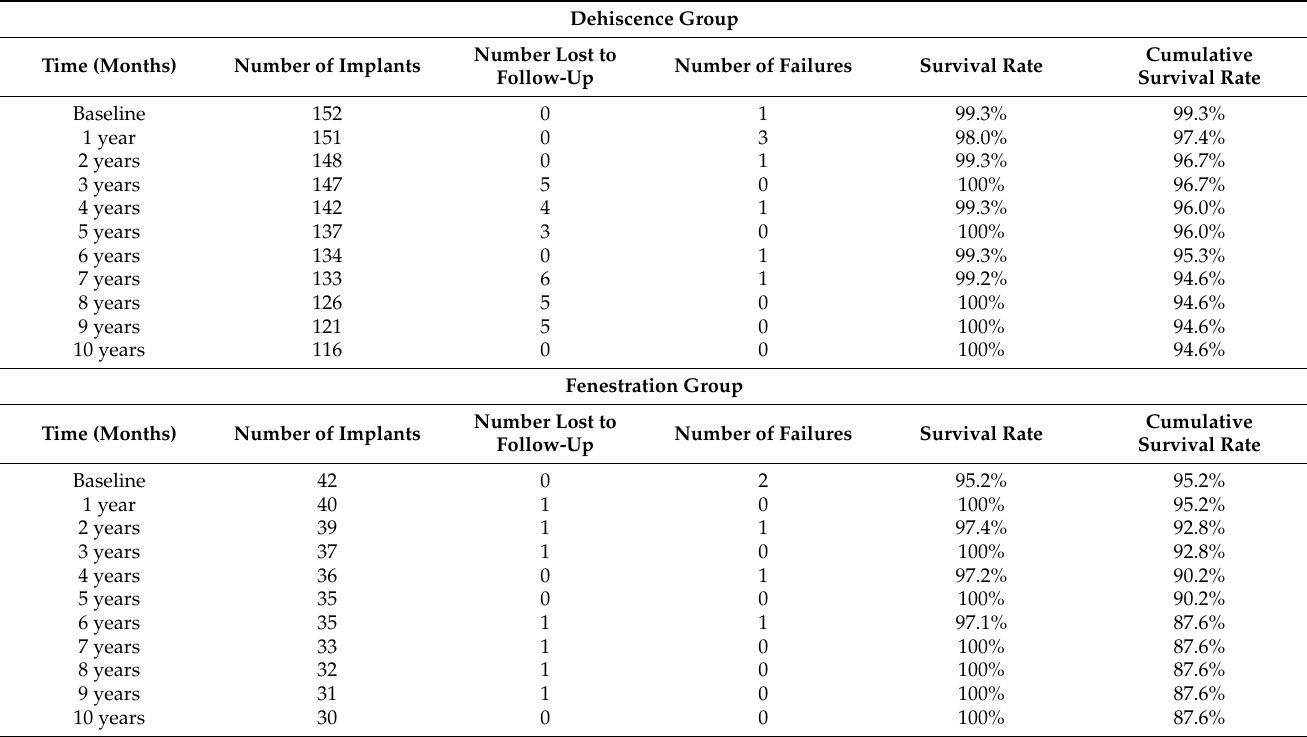
Table 5. Life tables for cumulative implant success rate using the implant as the unit of analysis: dehiscence and fenestration